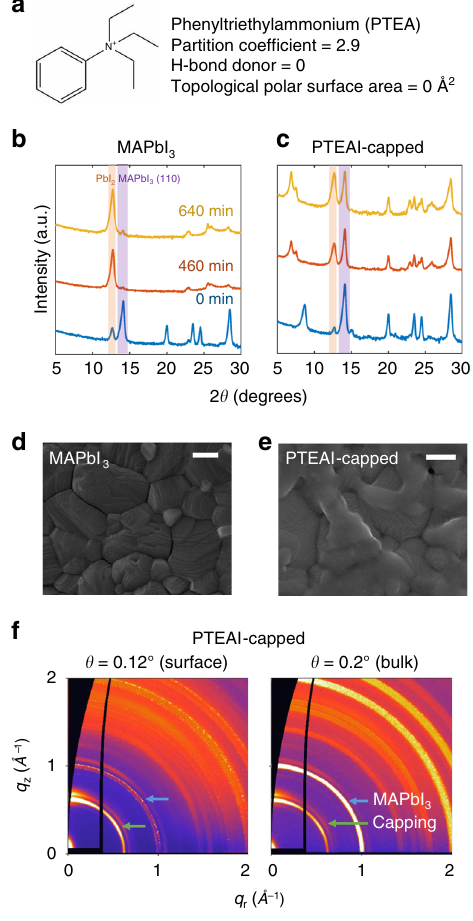
Fig. 4 Crystal structure and morphology characterization for optimum capping layer (PTEAI). a Phenyltriethylammonium (PTEA) has 0 hydrogen-bond donor due to its quaternary amine. Powder X-ray diffraction (XRD) spectra of bare ( b ) and PTEAI-capped MAPbI 3 ( c ), when they were degraded for 460 and 640 min The purple shaded area indicates the (110) peak of MAPbI 3 , and the orange shaded area indicates the (001) PbI 2 peak. Pre-degraded scanning electron microscopy (SEM) image of bare ( d ) and PTEAI-capped MAPbI 3 ( e ), scale bar: 200 nm. f Grazing-incidence wide- angle x-ray scattering (GIWAXS) images of PTEAI-capped MAPbI 3 presenting the structure on the surface and in the bulk fi lms, with the incident angles of 0.12° and 0.2°, respectively. The green arrow points to LD capping peak, and the blue arrow points to the MAPbI 3